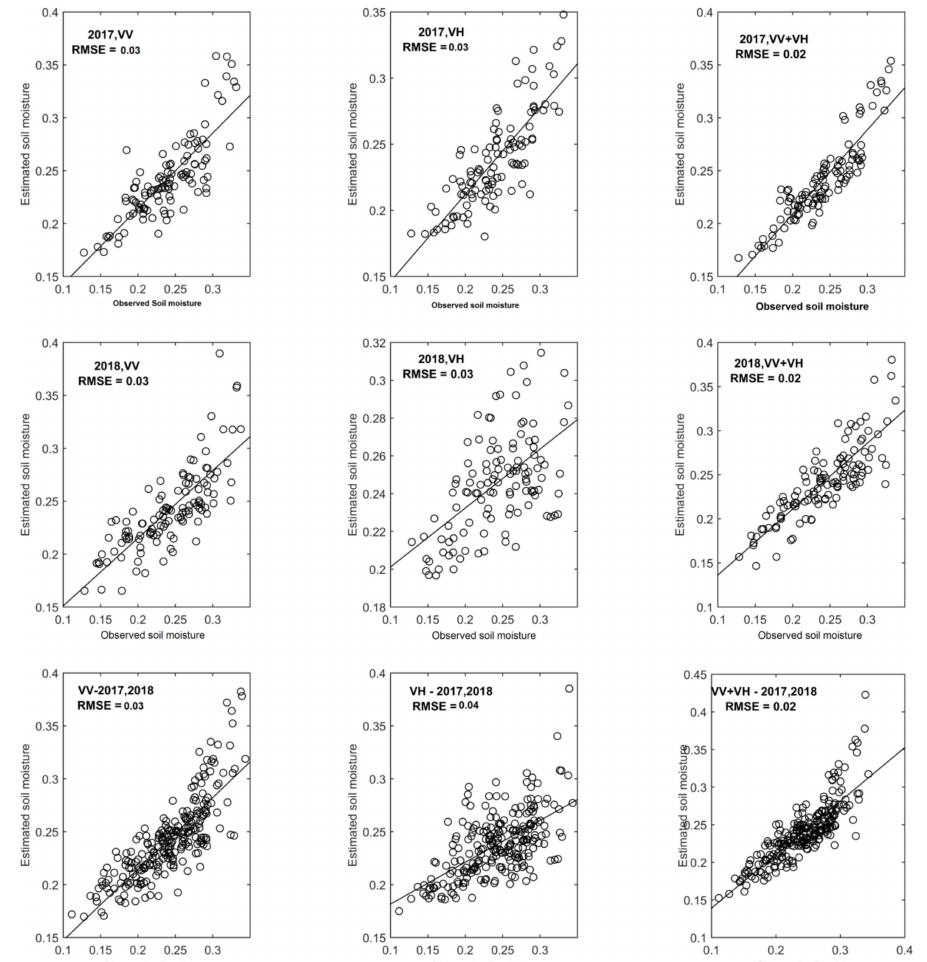
Figure 7. Generalized models. Validation between the estimated and observed soil